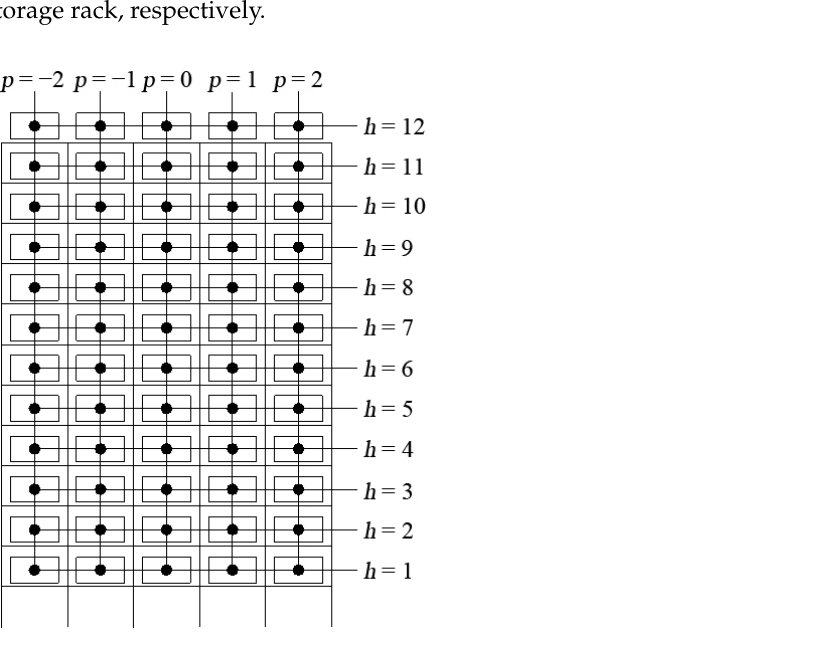
Figure 3. Diagram of the center of gravity and the eccentricity of steel storage racks with bracings.